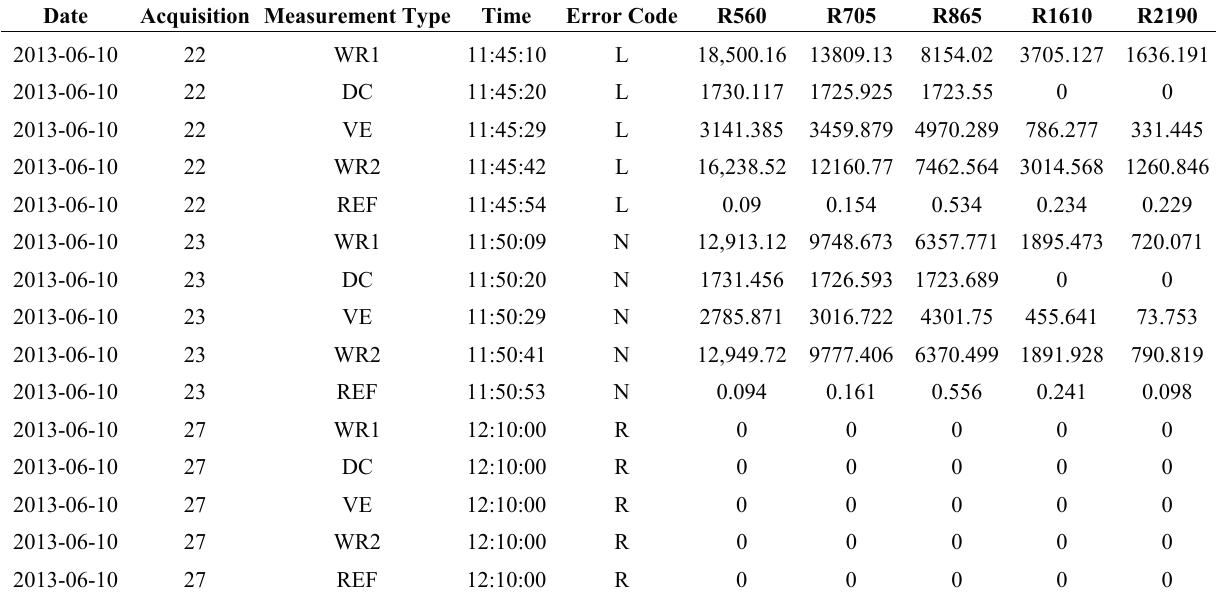
Table 1. A sample of WhiteRef hyperspectral system data stored in the LabVIEW output file, including some of the acquired radiance (digital number) and reflectance ( − ) values for a few selected